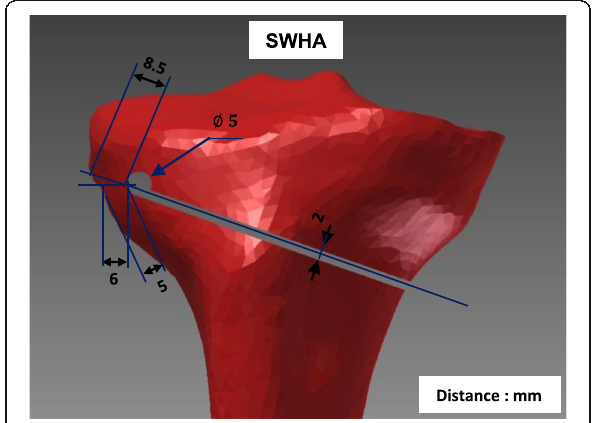
Fig. 3 Specimen SWHA: Specimen with the drilled hole as an extension of the osteotomy cut, but above the lateral end of it. The osteotomy cut was realised as for specimen SNH (Fig. 1) and the drill hole as for specimen SWHE (Fig. 1), butwas located about 2 mm proximally